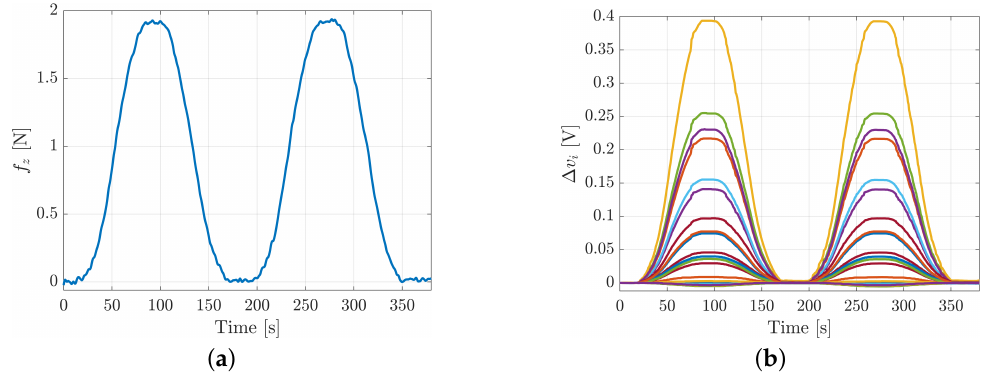
Figure 10. Repeatability experiment for taxel 17: applied force ( a ) and voltage variations ( b ).